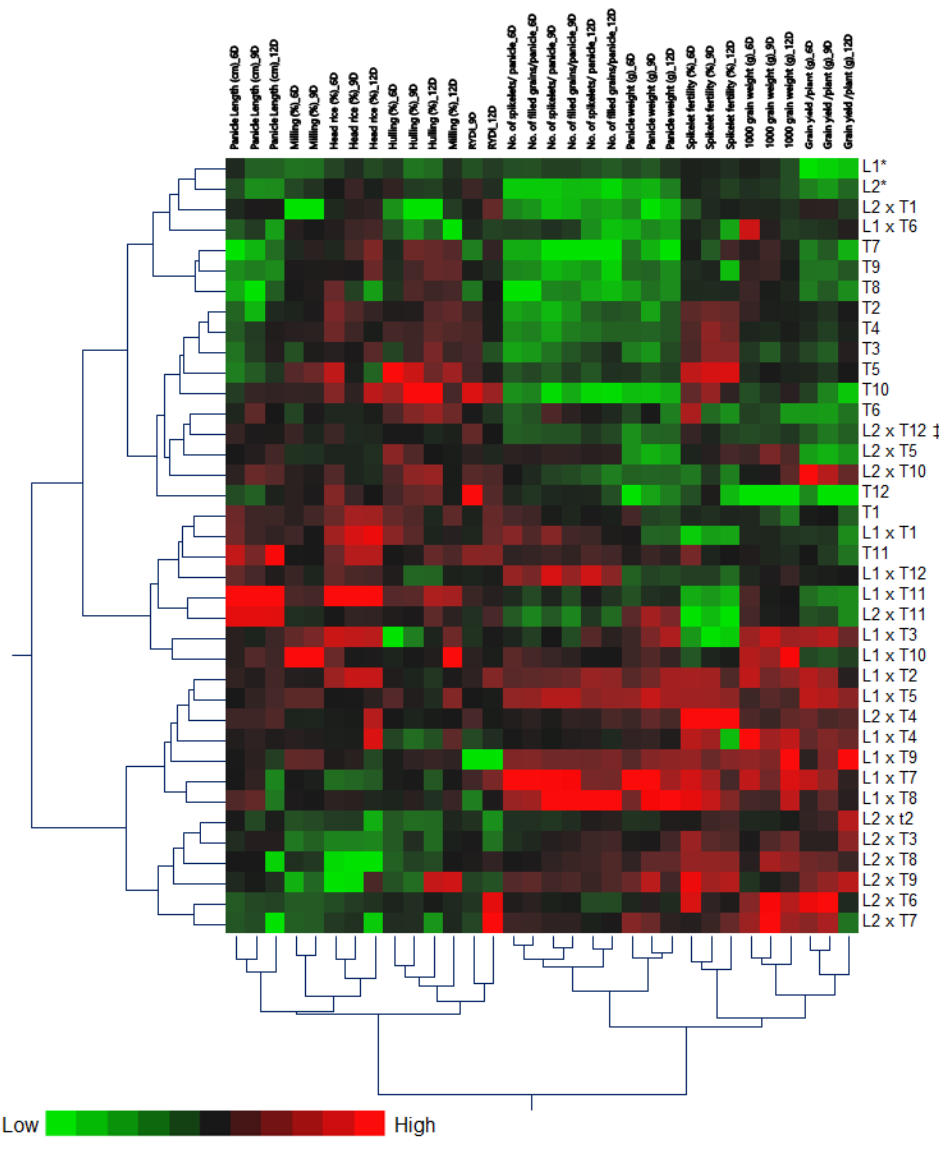
Figure 3. Two-way hierarchical cluster analysis (HCA) of individual response variables assessed in rice hybrids cultivated under three different irrigation regimes of 6, 9, and 12 days. Variations in the dependent variables among the studied rice hybrids are visualized as a heat map. Dependent vari- ables are presented in rows, while different treatments are presented in the column. The map pre- sents high numerical values in red and low numerical values in green (the scale is at the bottom left corner of the heat map). *: Line cultivar and ‡ : the check verity.